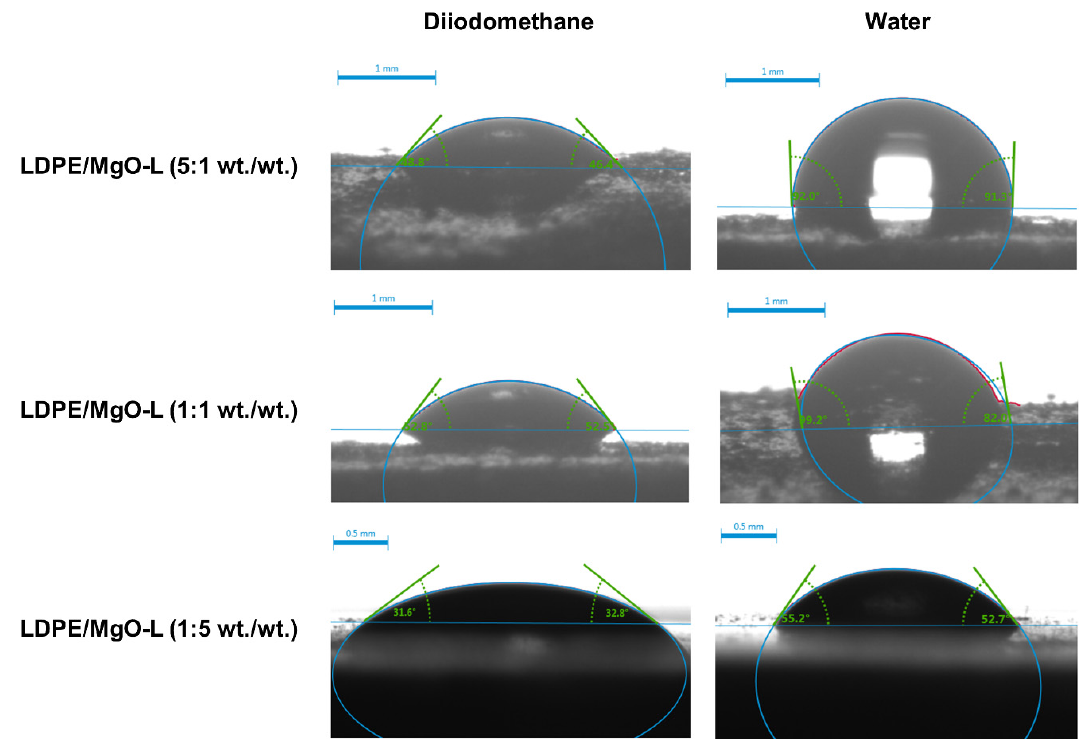
Figure 8. Diiodomethane and water contact angles for LDPE/MgO-L components.